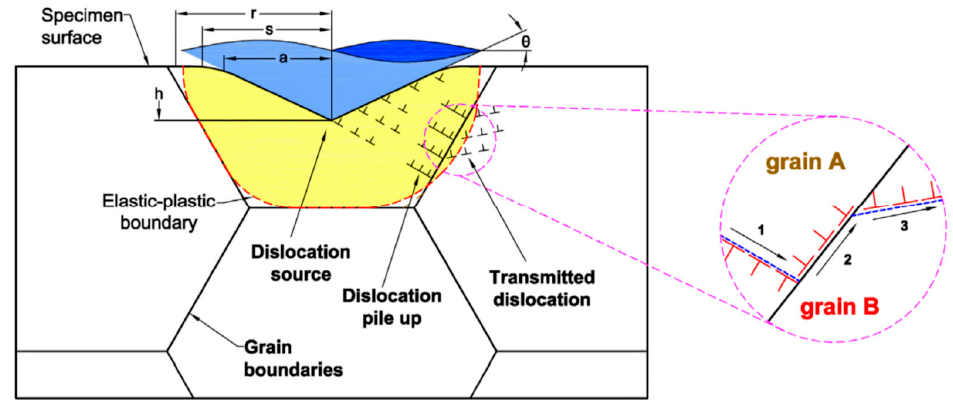
Figure 9. The schematic of the interaction between the GNDs and grain boundaries for polycrystalline metals during nanoindentation (after Voyiadjis and Zhang [107]).